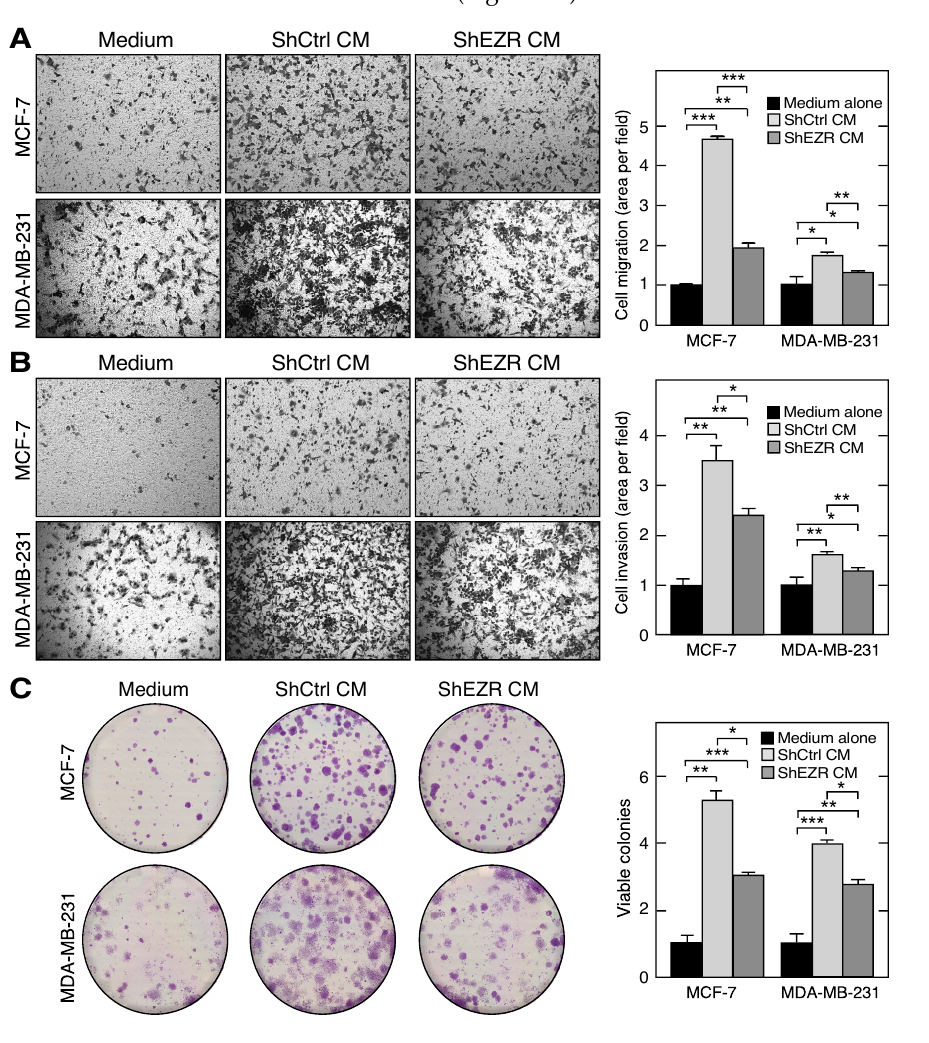
Figure 5. Role of myeloid cell ezrin in tumor cell migration, invasion, and clonogenic growth. ( A ) Trans-well migration of MCF-7 (upper panels) and MDA-MB-231 (lower panels) cells towards the complete RPMI medium (left), CM from M2-polarized ShCTRL (middle) and ShEZR (right) THP-1 cells. Area of transmigrated cells was quantitated (extreme right). ( B ) Matrigel invasion assay with conditions as in ( A ). ( C ) Clonogenic potential of MCF7 and MDA-MB-231 cells were determined in the presence of complete RPMI medium (left), and M2 CM from ShCtrl (middle) and ShEZR THP-1 cells (right). Number of colonies with greater than 50 cells was quantified (extreme right). Mean ± standard deviation; *, **, and *** indicate p < 0.05, 0.01, and 0.001,